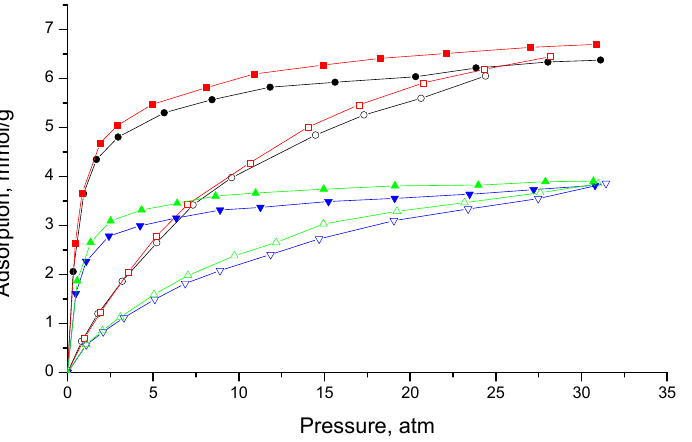
Figure 4. Adsorption isotherms for the samples ▼ — 2solv , ▲ — 3solv , ● — 2solv-after-rinsing and ■ — 3solv-after-rinsing at 298K. Hollow symbols—methane adsorption, solid symbols—ethane ad- sorption.